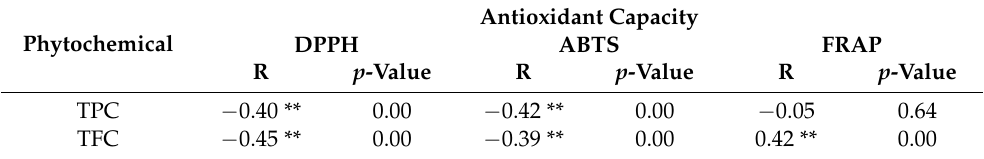
Table 3. The Pearson correlation between the phytochemical contents and antioxidant capacities of the dried bamboo extracts.